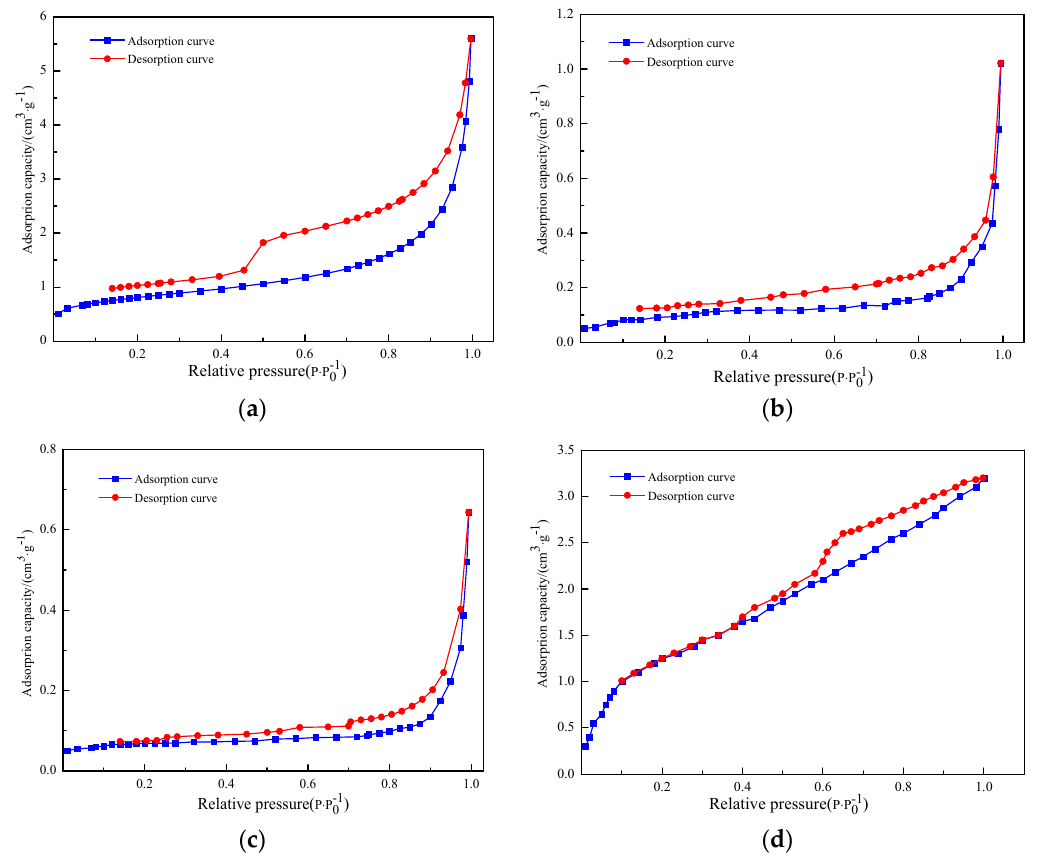
Figure 5. Low-temperature nitrogen adsorption and desorption isotherms. ( a ) HY; ( b ) SY; ( c ) XZ; ( d ) ( d ) DJH.